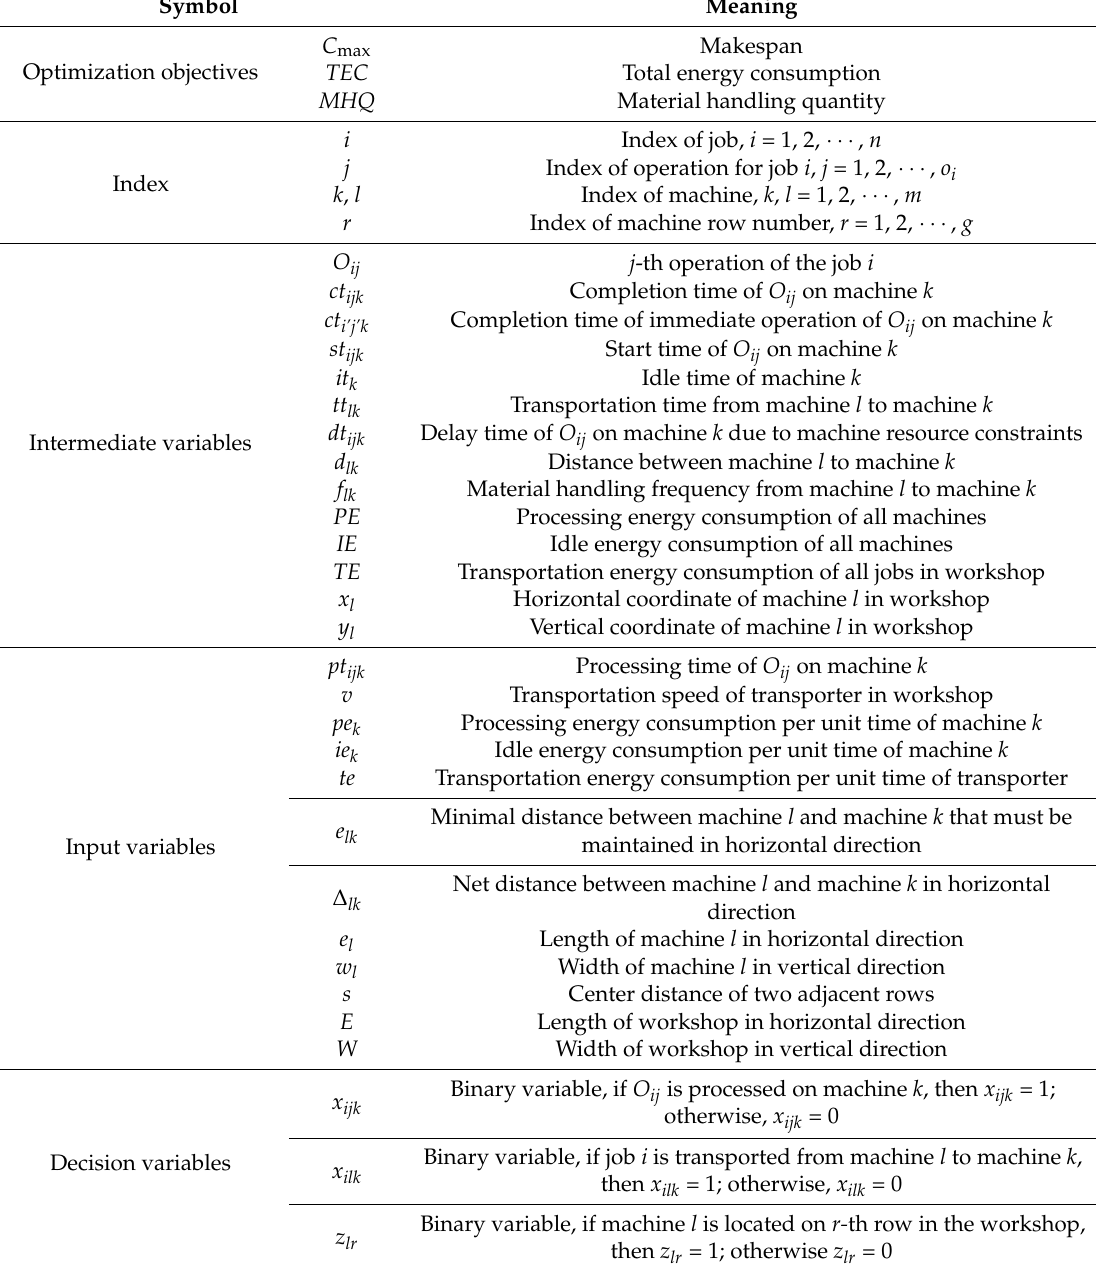
Table 1. The notations used in this